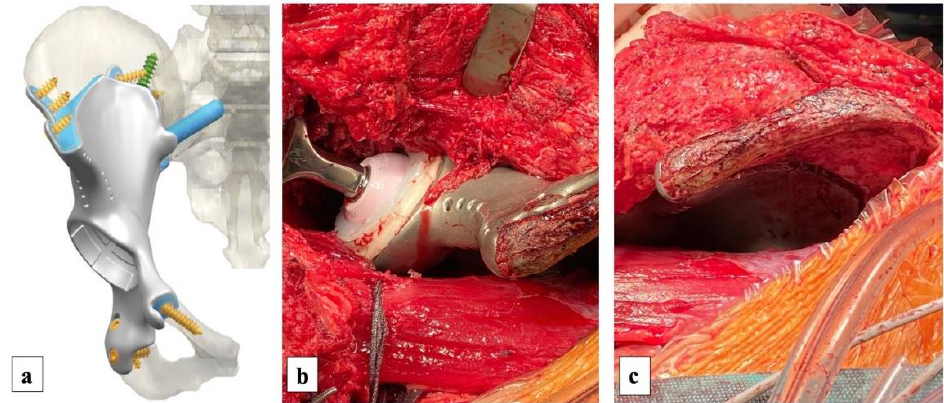
Figure 6. Preoperatory 3D setup of the custom-made implant ( a ) was used to analyse the possibilities of fixation to the host bone. In addition to the provided design, we asked for reinsertion holes for the tensor fascia lata muscle, the sartorius muscle, the rectos femoris muscle and the rectos femoris reflected tendon. After the reconstruction, the application of the implant was perfectly sealed to the host bone ( b , c ).